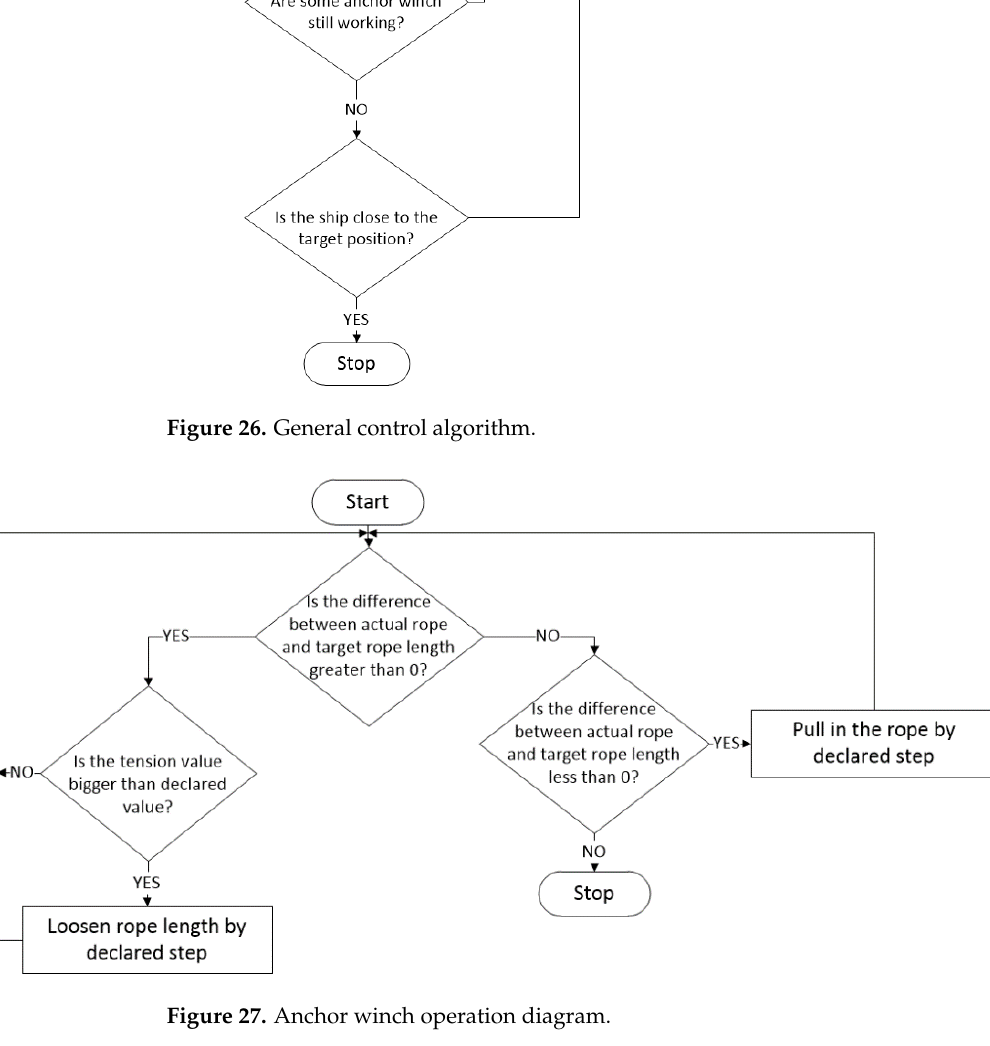
Figure 27. Anchor winch operation diagram.